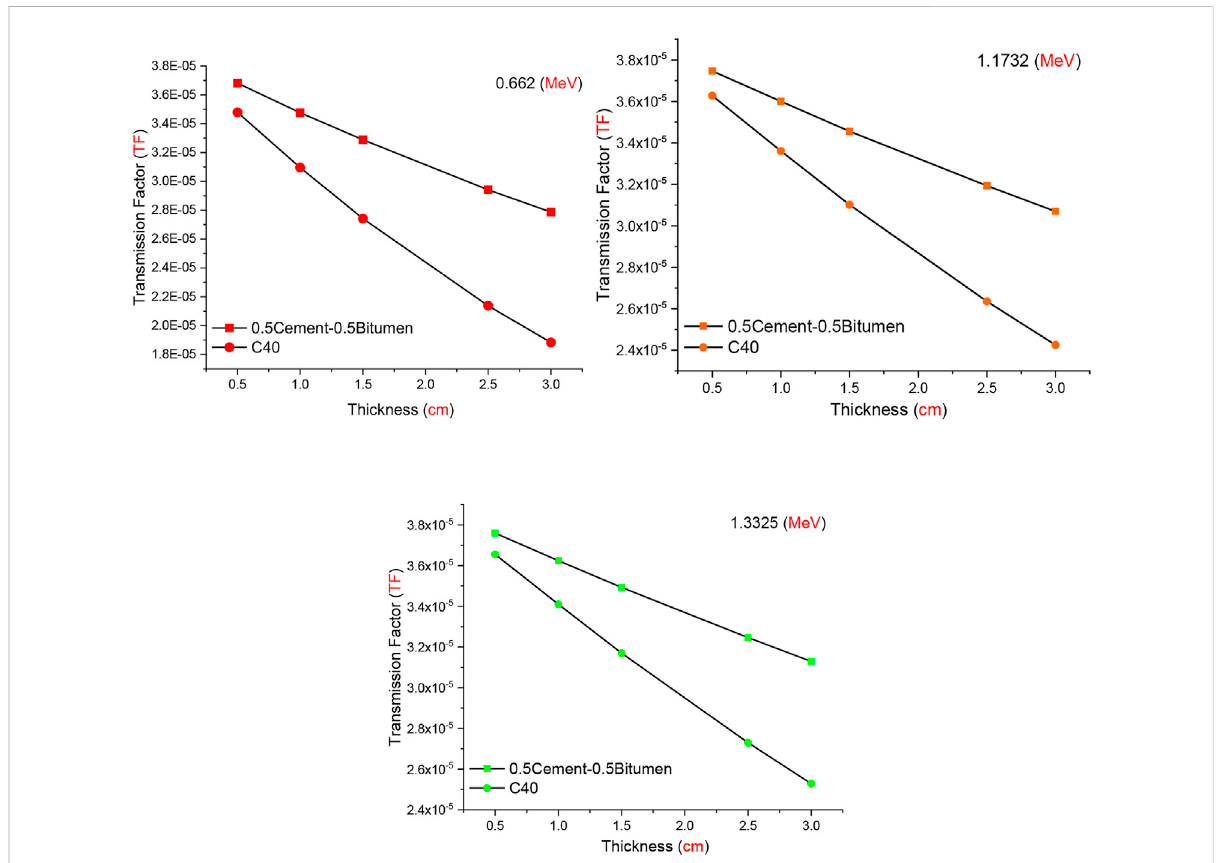
FIGURE 5 Variation of TFs as a function of material thickness for 0.5 Cement-0.5 Bitumen and C40 glass